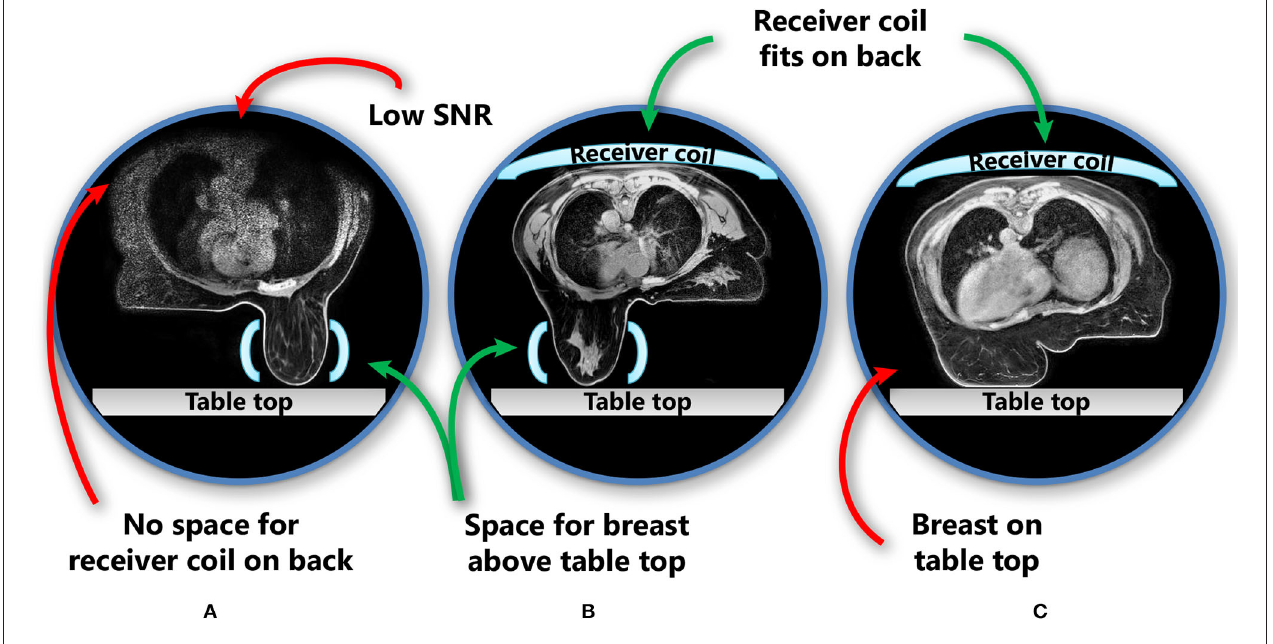
FIGURE 2 | Patient and receiver coil positioning in prone position, including challenges in this position. The images show three different patients. (A) No space for the receiver coil on the back of the patient if the breast hangs freely without touching the scanner table; (B) the receiver coil fits above the patient while also the breast hangs freely; (C) when the receiver coil is fitted in the MRI bore above the patient, the breast touches the table top and is deformed. Light blue shapes represent the receiver coils (horizontal: receiver coil array; vertical: single flex coil). SNR, signal-to-noise ratio.